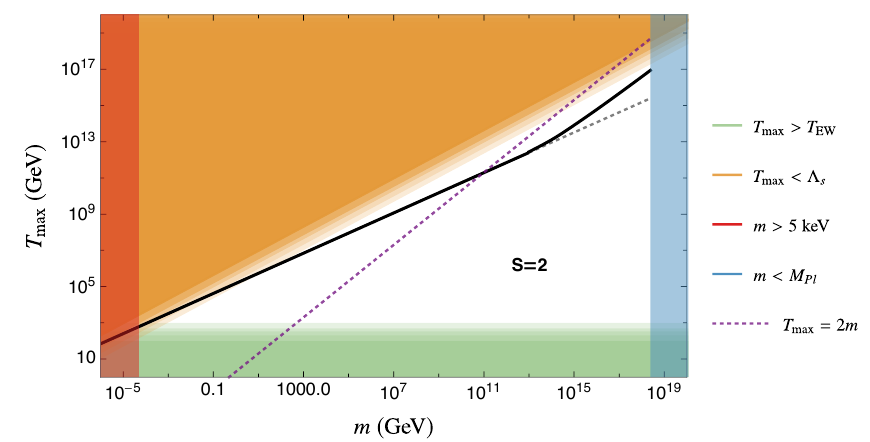
Figure 2: Spin-2 DM gravity-mediated scenario without contact terms. For a given DM mass m , the black line shows the maximum temperature of the universe needed to obtain correct relic abundance from freeze-in. The dashed-gray line indicates the simple estimate for T based on dimensional analysis, cf. Eq. (9). The lower bound max on the DM mass, m (cid:166) 5 keV, is due to small-structure formation constraints, and the upper bound is the Planck scale. The orange region is excluded by perturbativity con- straints on the EFT, requiring the separation between the strong coupling scale and T to be α = 1 / 20. The green region corresponds to T below the electroweak max max scale.